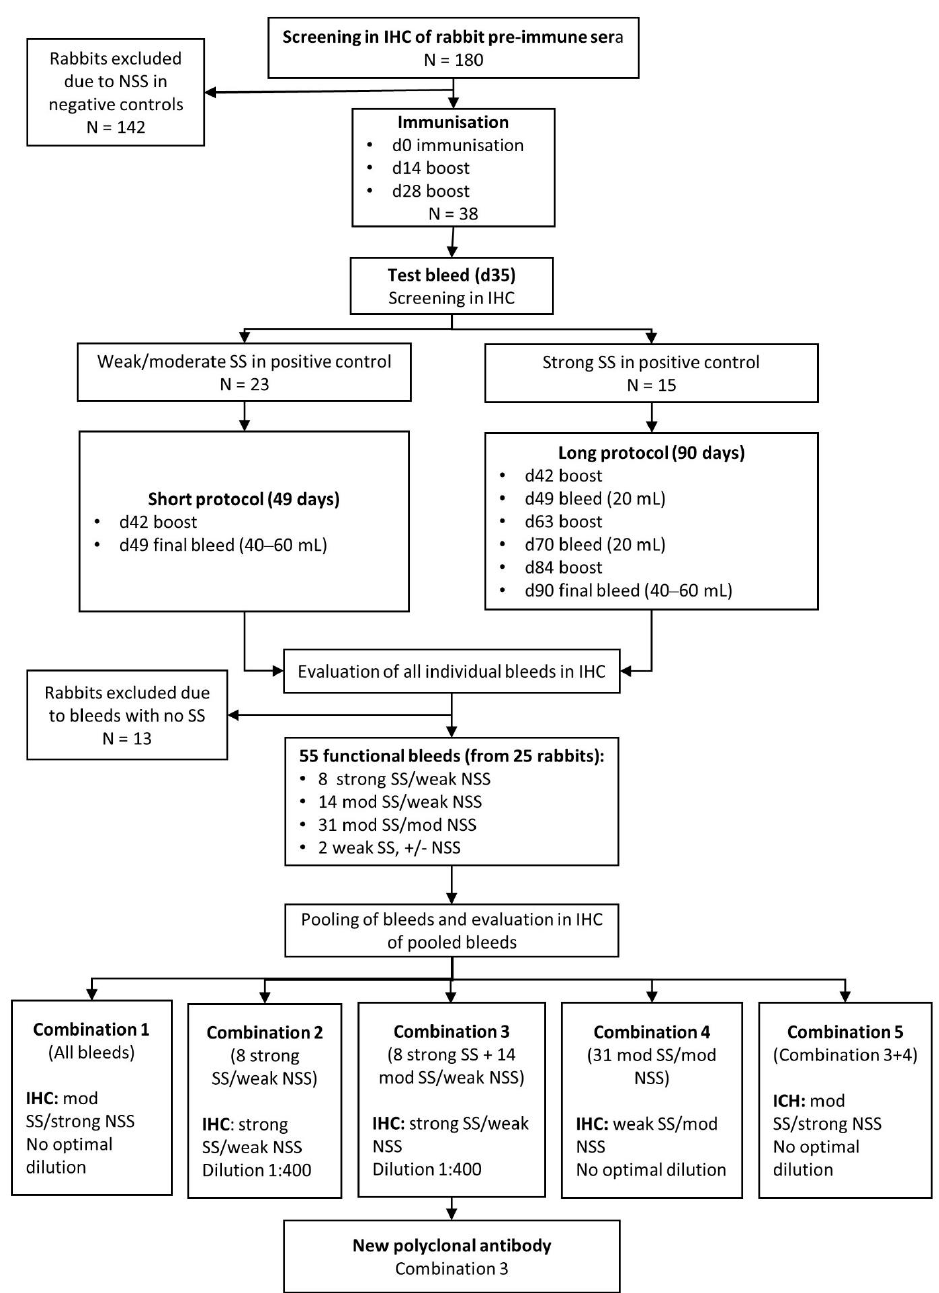
Figure 3. Flow chart showing immunisation protocols, screening and pooling strategies used to develop the new polyclonal antibody (polyclonal antibody experiment 4). Abbreviations: d, day; IHC, immunohistochemistry; mod, moderate; NSS, non-specific staining; SS, specific staining.